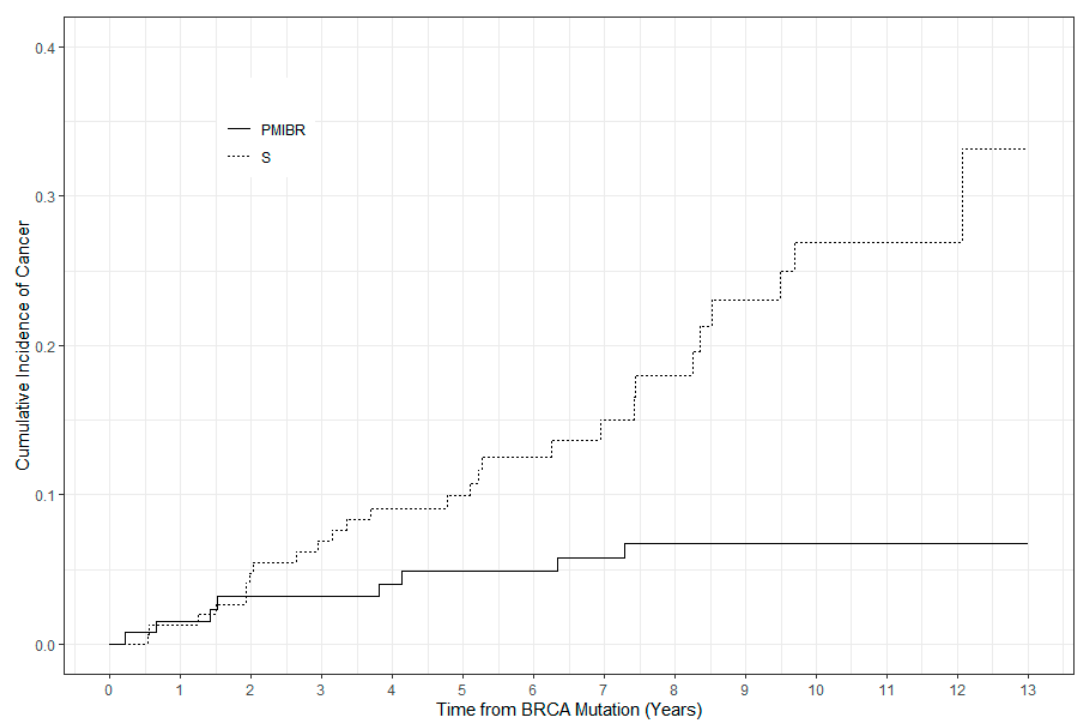
Figure 1. Mutation carriers choosing prophylactic mastectomy with immediate breast reconstruction vs. BRCA1/2 mutation carriers choosing surveillance.